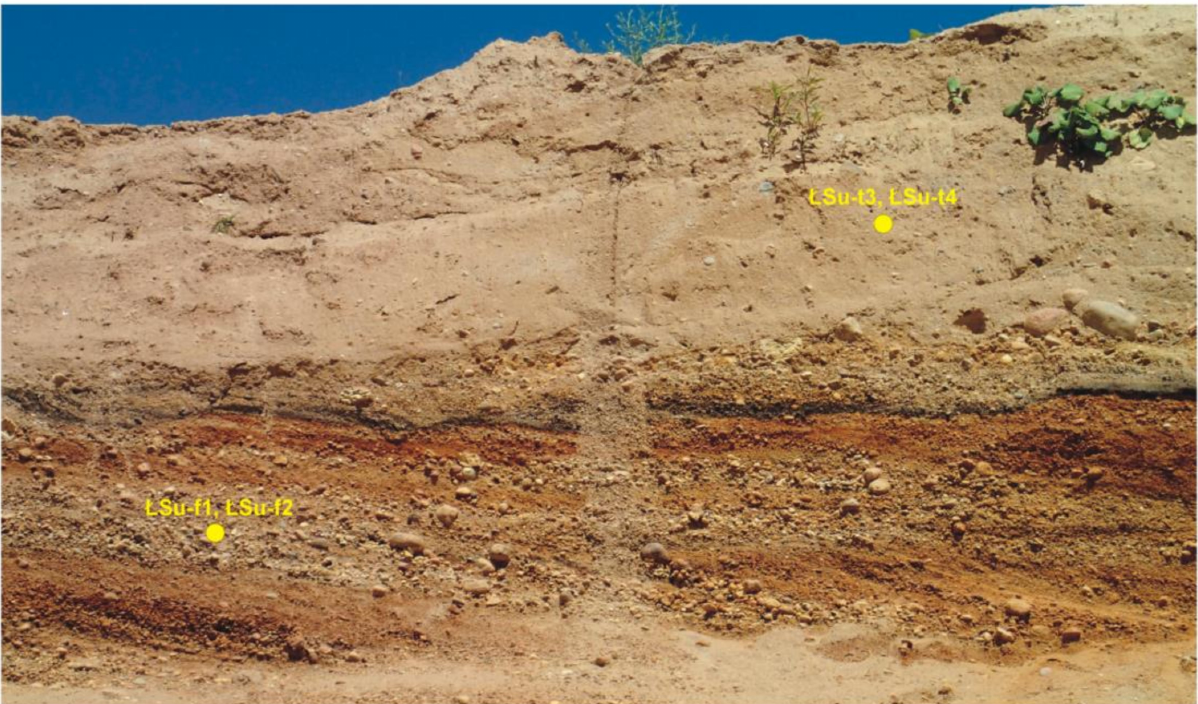
Figure 3. General view of pit wall B with unit ŁS I and ŁS II at the top; sampling sites, as well as the ice-wedge pseudomorph are